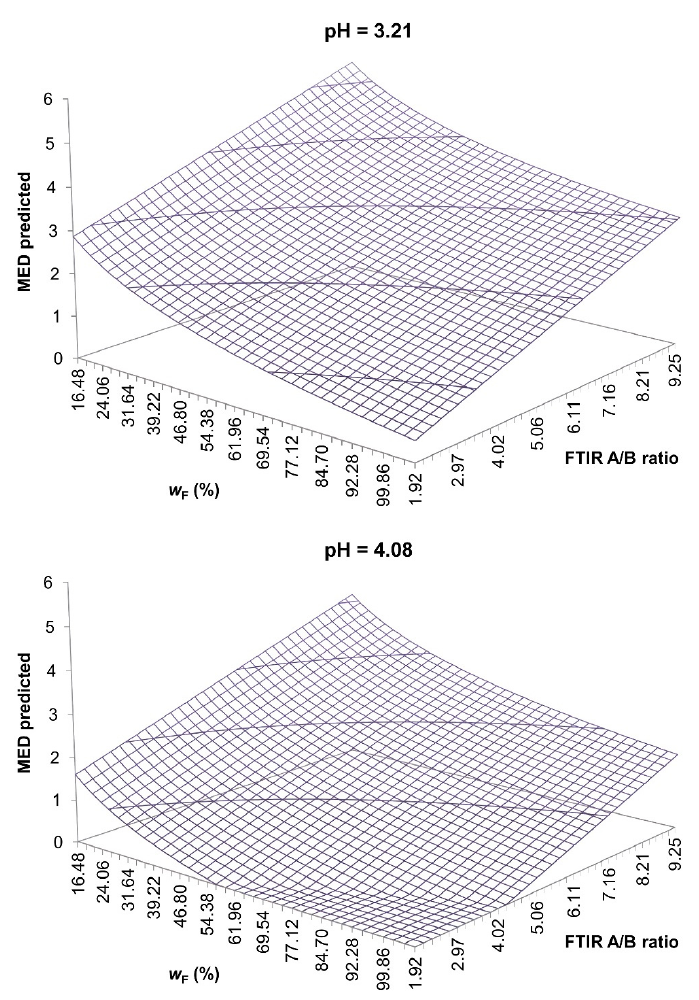
Figure 4. Two grids showing general trend in MED value change as a result of soil moisture (w F ), FTIR A/B ratio, and soil pH variation. In each of the two graphs, a fixed pH value is used for the prediction (3.21 in the upper and 4.08 in the lower panel; these represent the lowest and the highest detected pH values among 45 topsoil samples). Used regression equation: MED = − 2.93 Log w F + 0.35 (A/B)–1.46 pH + 10.43 (R 2 = 0.71, F = 33.39, p = 2.51 10 − 21 , d.f = 41).